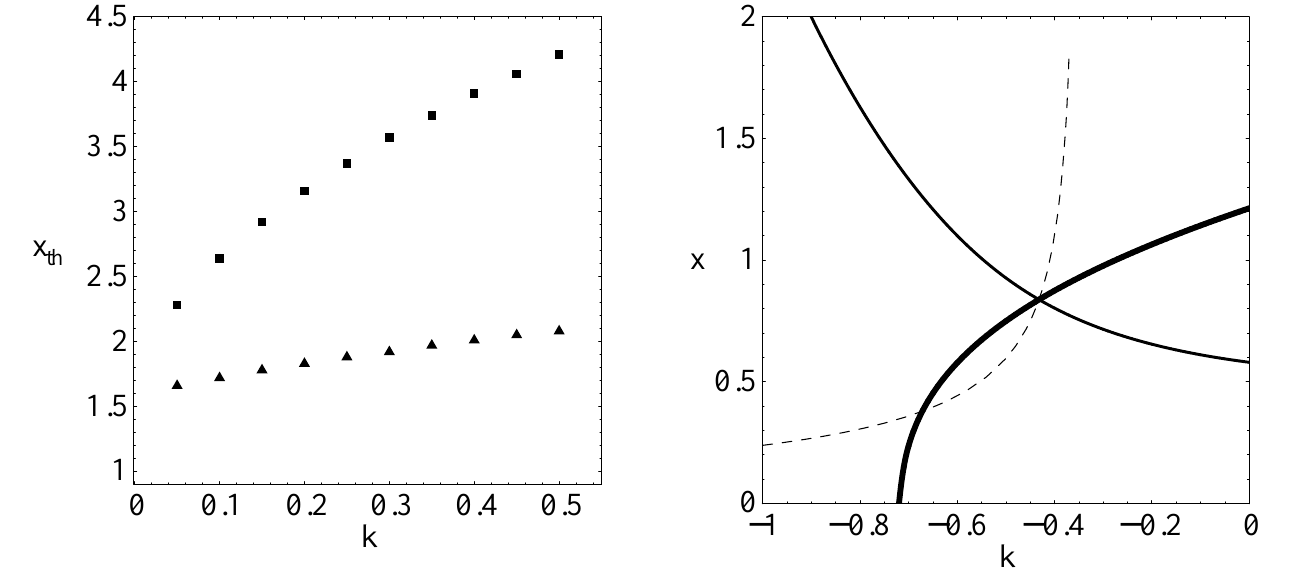
FIG. 4. The flip-flop threshold x th vs the positive slope k in FIG. 5. Limiting curves of solutions in the model of linear (19), n (cid:1) 0.01 (top), n (cid:1) 0.1 (bottom). variation of beam emittances with the lens of the opposite bunch. Normal solutions exist under the dashed line. Unequal b 1 , b 2 appear for all values of k above the upper of the two solid The requirement for b to be real and positive leads to conditions on a of 0 , a , 1 .